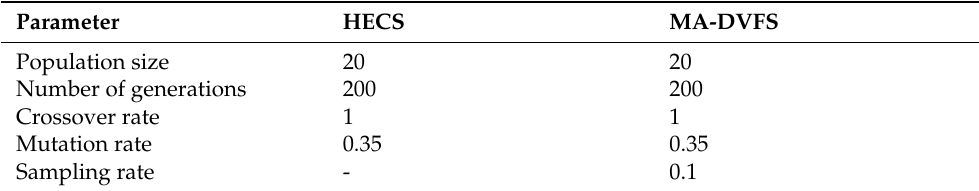
Table 3. Evolutionary